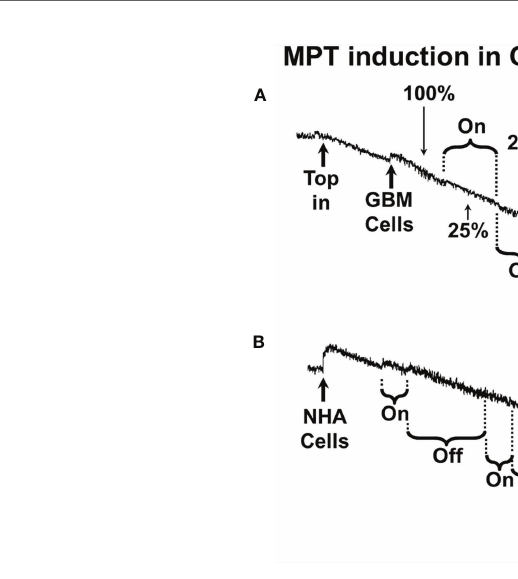
FIGURE 5 | sOMF stimulation of GBM and NHA cells. (A) Mitochondria of some primary GBM cultured cells can undergo MPT after repeated cycles of magnetic stimulation. (B) Mitochondria of NHA do not undergo MPT with magnetic stimulation. The addition of FCCP at the end of the trace shows that their mitochondria are undamaged and coupled after sOMF